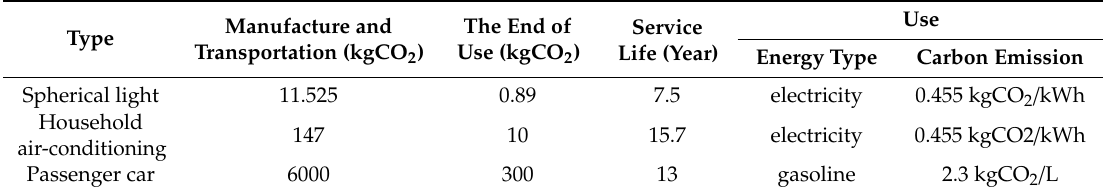
Table 1. The carbon emission parameters of the equipment life cycle [30,36–38].